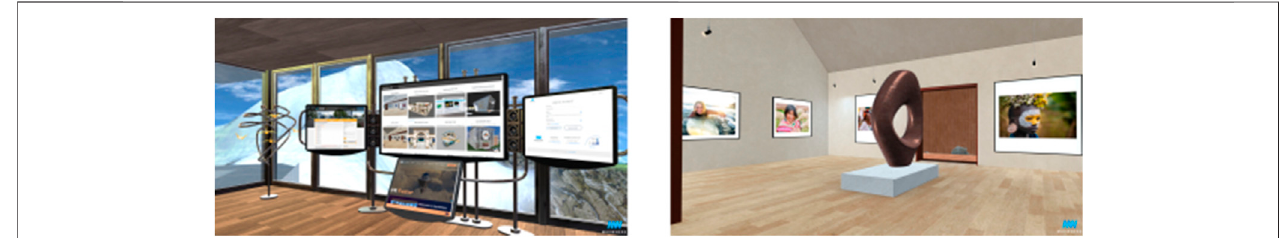
FIGURE 2 | 2D content inside MaxWhere 3D